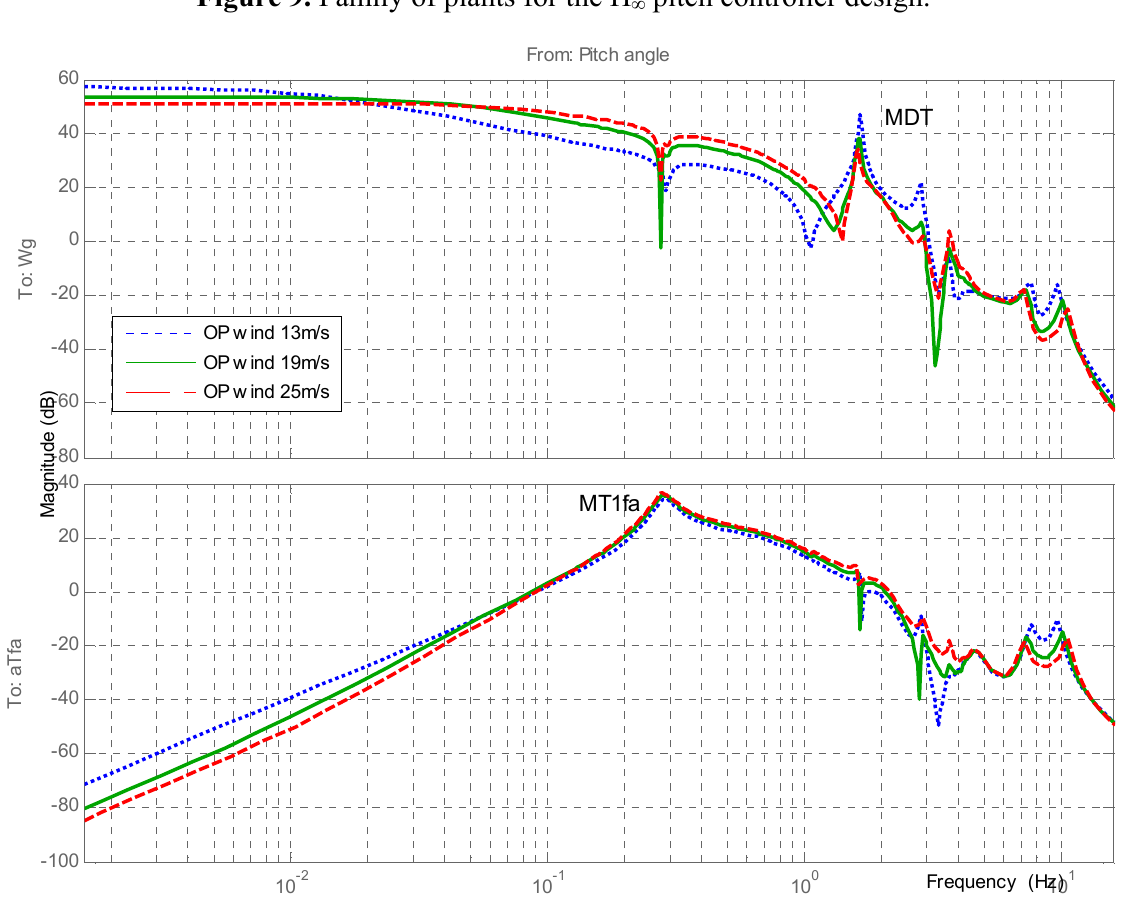
Figure 9. Family of plants for the H